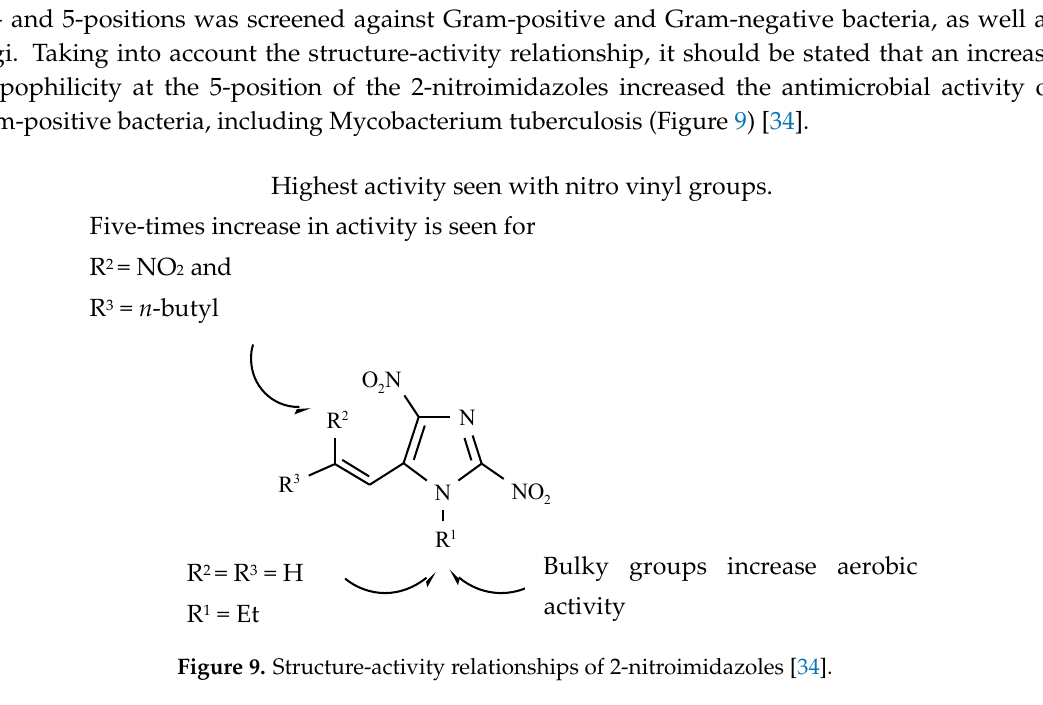
Table 4. Antibacterial 5-nitroimidazole derivatives.